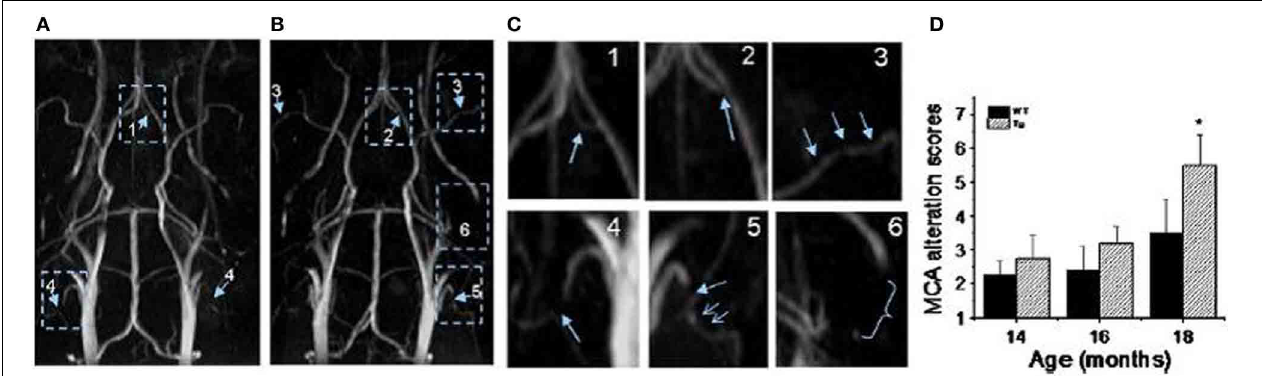
FIGURE 7 | MR angiography of transgenic mice modeling AD. (A,B) MR angiograms of 18-month-old Tg2576 mice collected at 17.6 T showing various levels of severities of morphological changes appointed in 3D maximum intensity projection. The number indicates the appointed score to the level of severity of alterations. For example: 1, a flow disturbance (as seen in anterior communicating artery in image A ); 2, a small signal void (as observed at the origin of anterior communicating artery in image B ); 3, more than two small voids in same artery (as observed on the middle cerebral artery (MCA) on both sides in image B ); 4, an extended